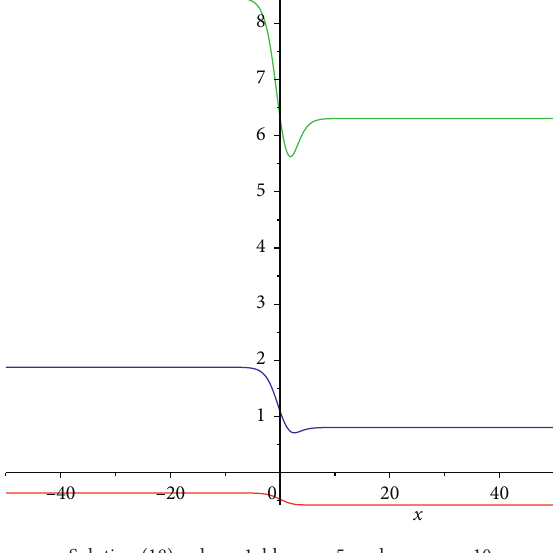
� √ , μ � 0 . 3 , c � 0 . 1 ,t � 10 , and C 2